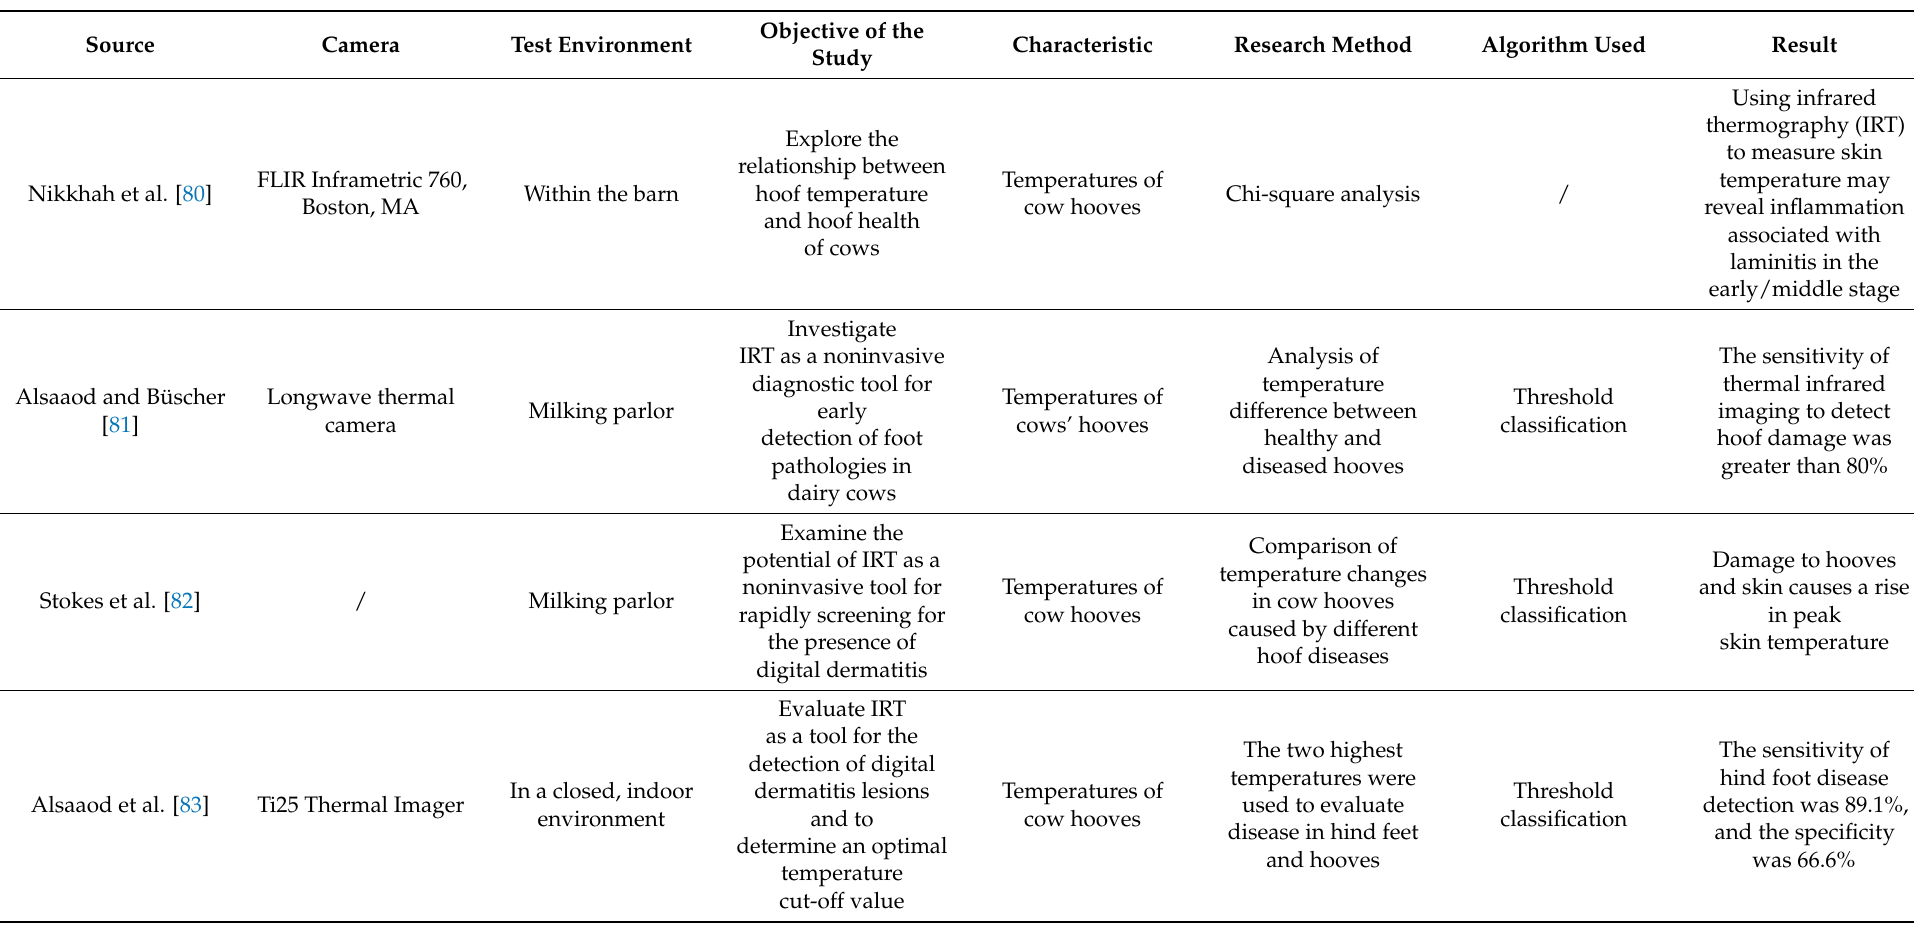
Table 2. Detection method of cow lameness based on 3D and thermal infrared